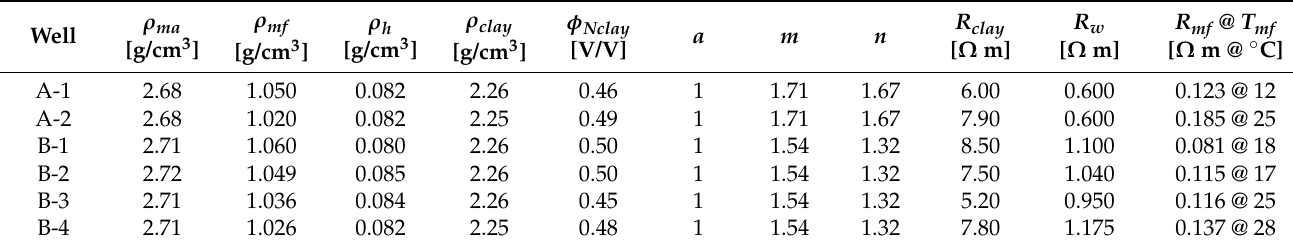
Table 4. Main log-derived and core-derived parameters used for the effective porosity ( φ e ) and water saturations ( S xo , S w ) evaluation in the reservoir intervals of “A” and “B” fields.